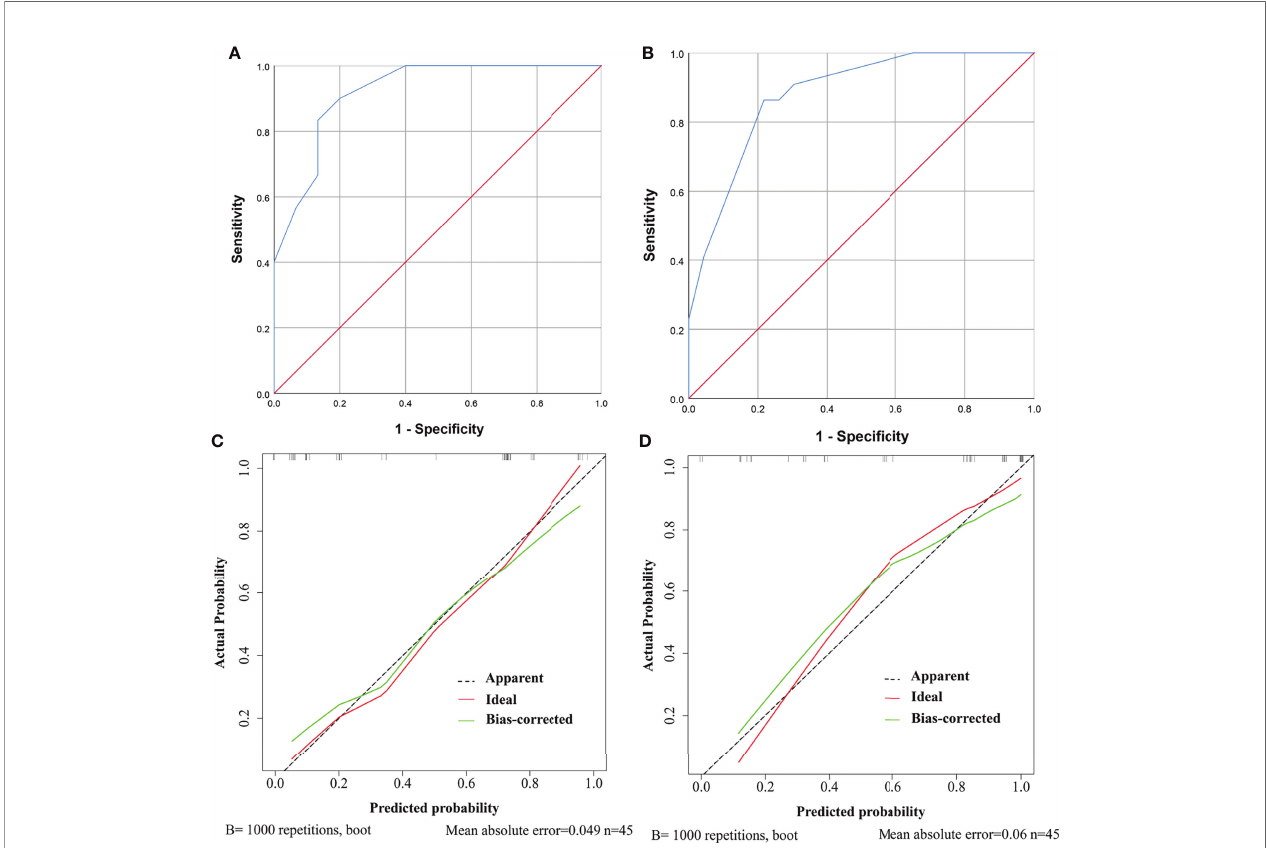
FIGURE 5 | ROC curves and calibration curves of the models showing predictive performance for need for anterior pituitary hormone replacement 1 year after surgery and permanent diabetes insipidus (DI) in the validation cohort. (A) The AUC of the model for need for anterior pituitary hormone replacement is 0.921, with 95% CI ranging from 0.834 to 1.000. (B) The AUC of the model for permanent DI is 0.880, with 95% CI ranging from 0.782 to 0.979. (C) Calibration curve of the prediction model for need for anterior pituitary hormone replacement. The grey dashed line represents the apparent curve (non-correction), the green line represents the bias-correction curve, and the red line represents the ideal curve. B = 1,000 repetitions; n = 45, mean absolute error = 0.049. (D) As in (C) but for permanent